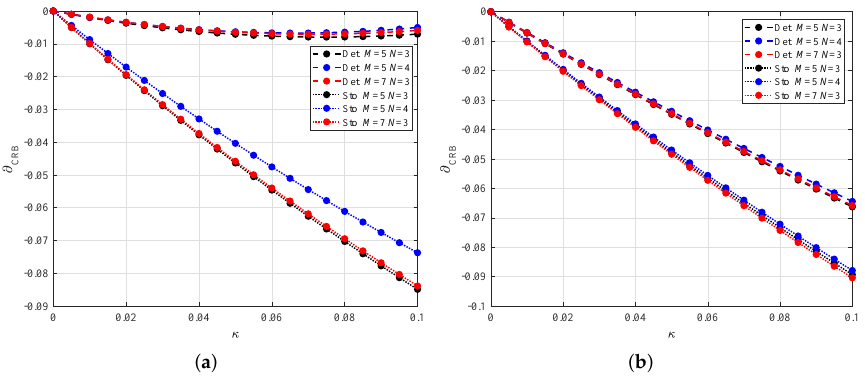
and ∂ CRB versus κ . ψ θ